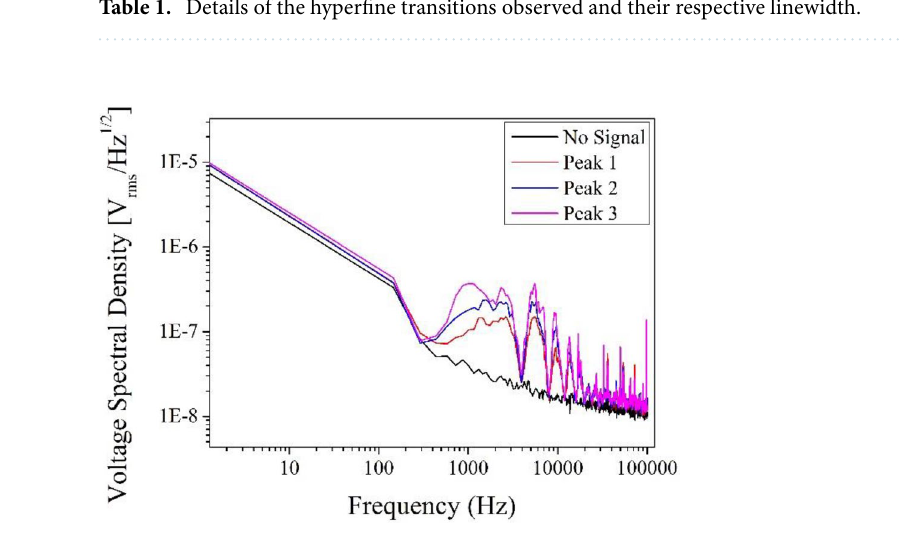
Figure 3. Voltage spectral density of noise floor of the spectrum analyser (black) and error signals generated through the SAS peaks corresponding to the hyperfine transitions F g = 3 to F e = 4 (Peak 1—red), F g = 3 to F e = CO34 (Peak 2—blue) and F g = 3 to F e = CO24 (Peak